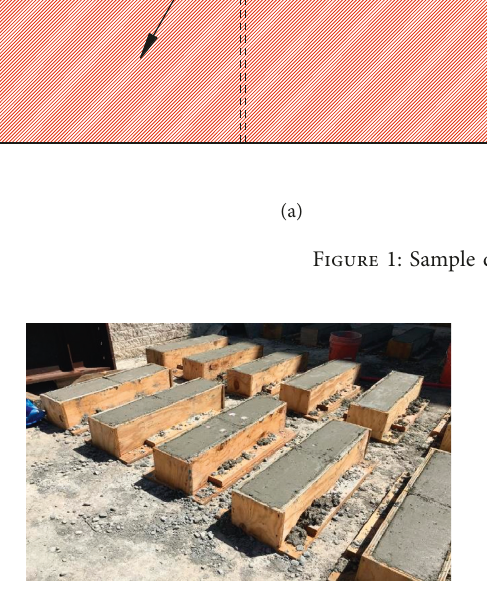
Figure 2: Concrete beam specimens. Table 2: CFRP-cured laminate properties.